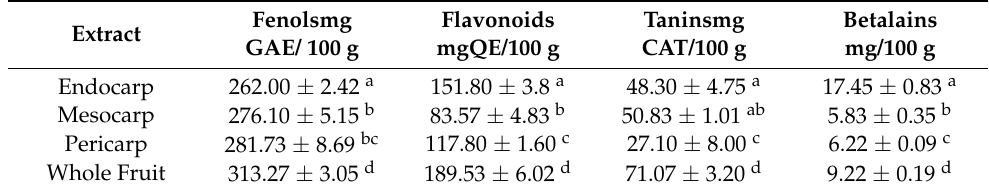
Table 1. Content of bioactive compounds in extract of xoconostle variety Ulapa ( Opuntia Oligacantha C.F. Först ).